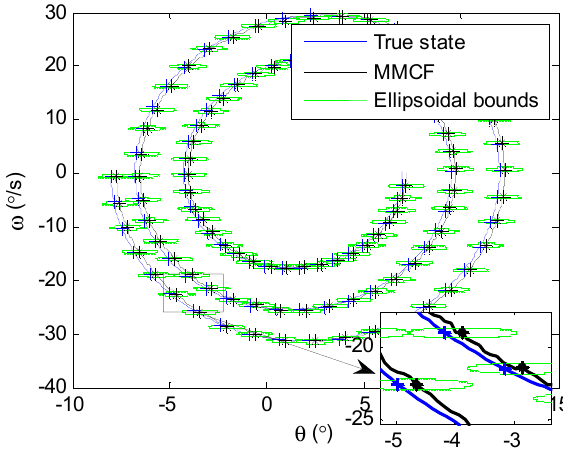
Figure 7. Phase-plane estimation using the MMCF. Sensors 2018 , 18 , x FOR PEER REVIEW